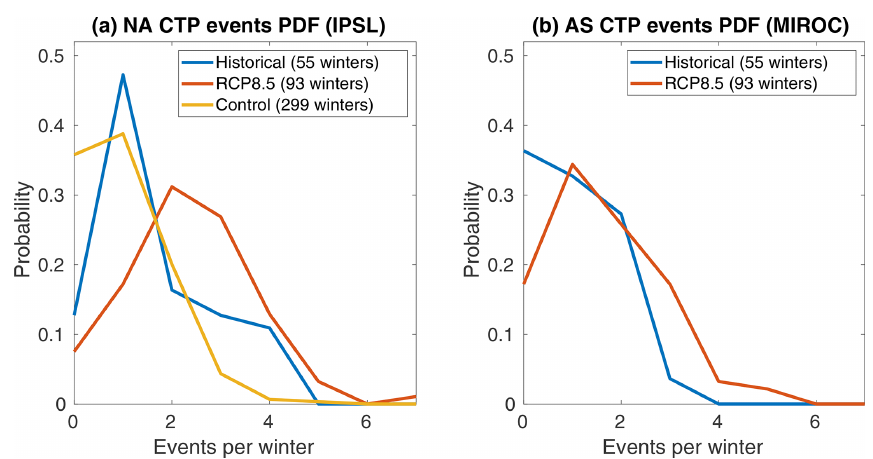
Figure 9. Histograms of the probability of CTP event frequency per winter, for (a) IPSL-CM5A-MR and the NA region and (b) MIROC- ESM-CHEM and the AS region. The blue, red, and yellow lines signify the historical (1950–2005), RCP8.5 (2005–2099), and pre-industrial control (1800–2099) runs,